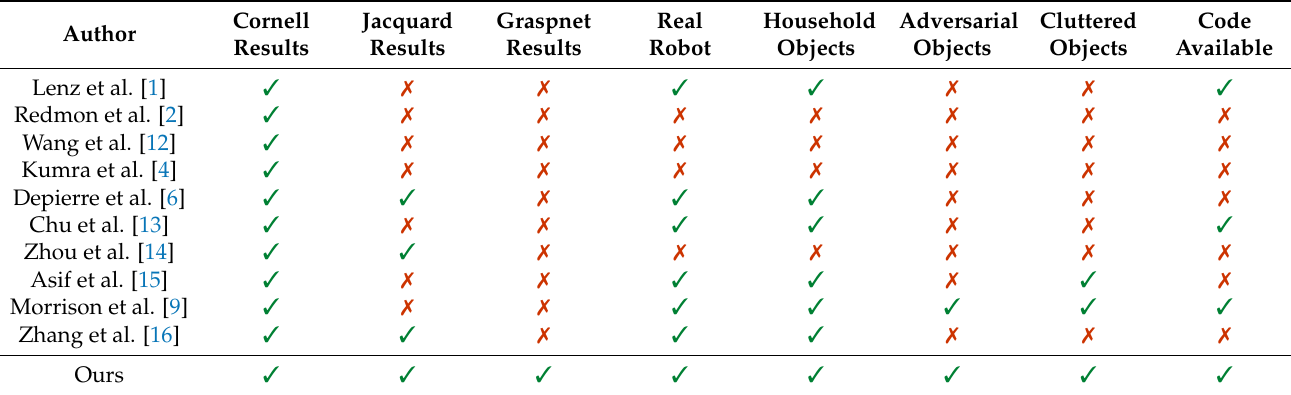
Table 1. A comparison of related